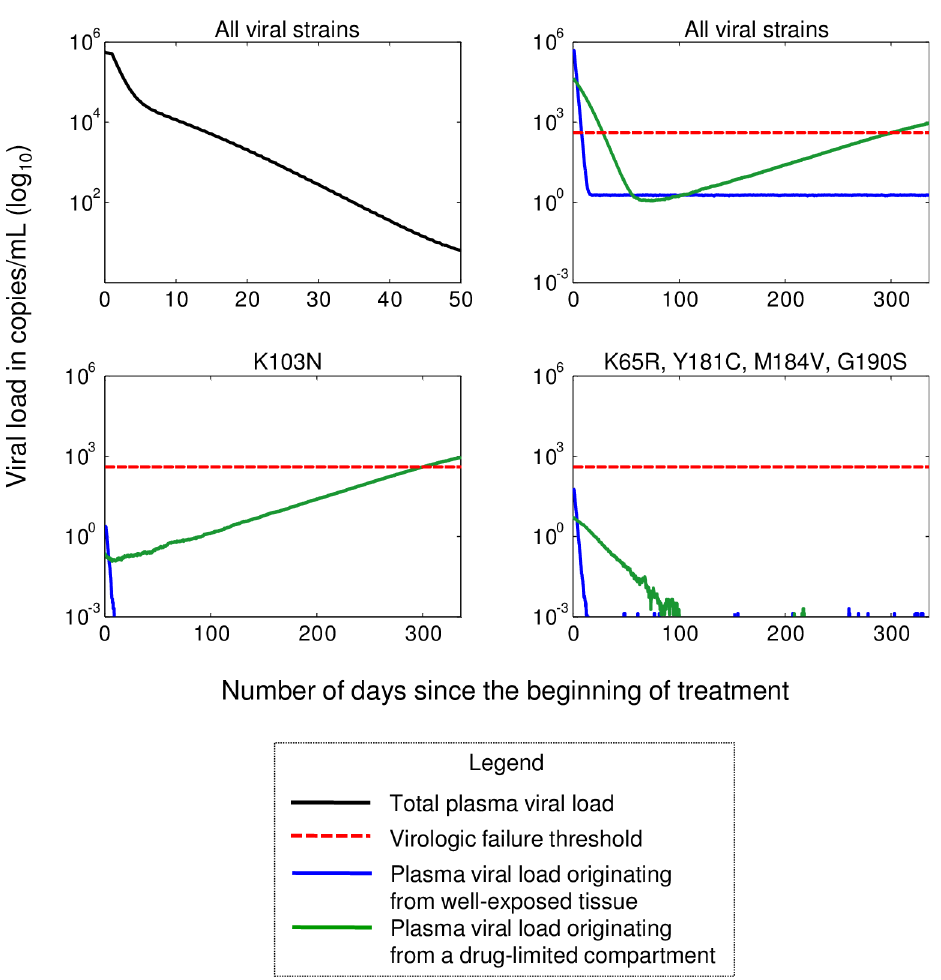
Fig 5. Simulation results for one random patient after 48 weeks of therapy with efavirenz (600mg), tenofovir DF (300mg) and emtricitabine (200mg) taken once daily. The model included a drug-limited compartment that allowed new short-lived cell infections. The virologic failure threshold was set at 400